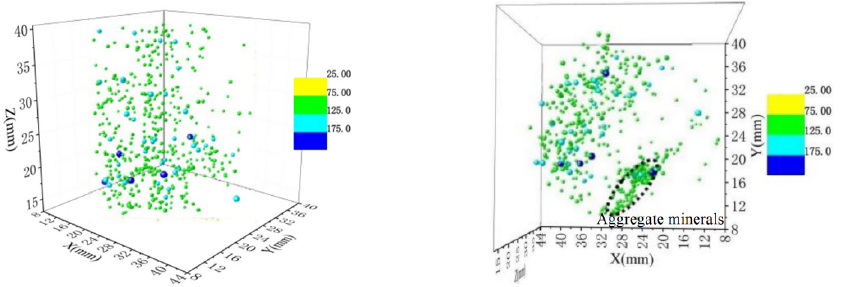
Figure 11. Spatial distribution of large-size mineral particles.